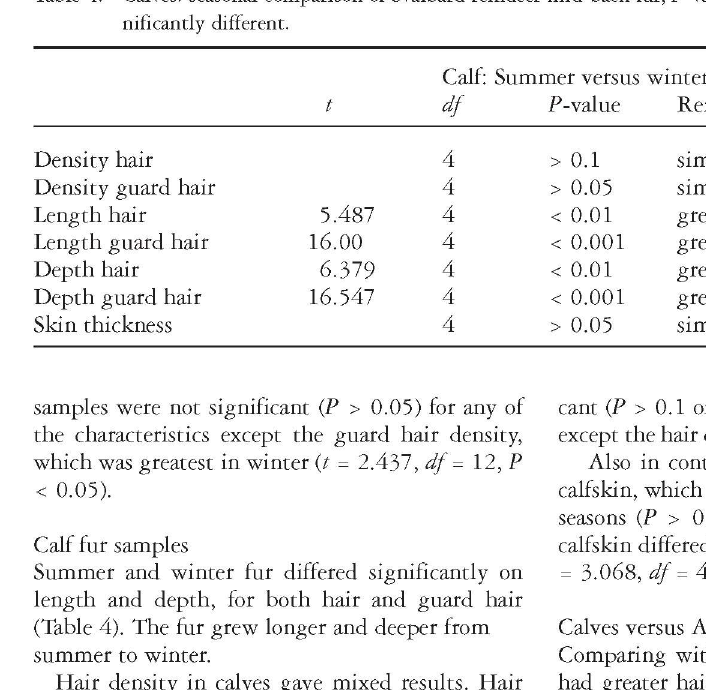
Table 4. Calves: seasonal comparison of Svalbard reindeer mid-back fur, P -values below 0.05 were considered sig¬ nificantly different.